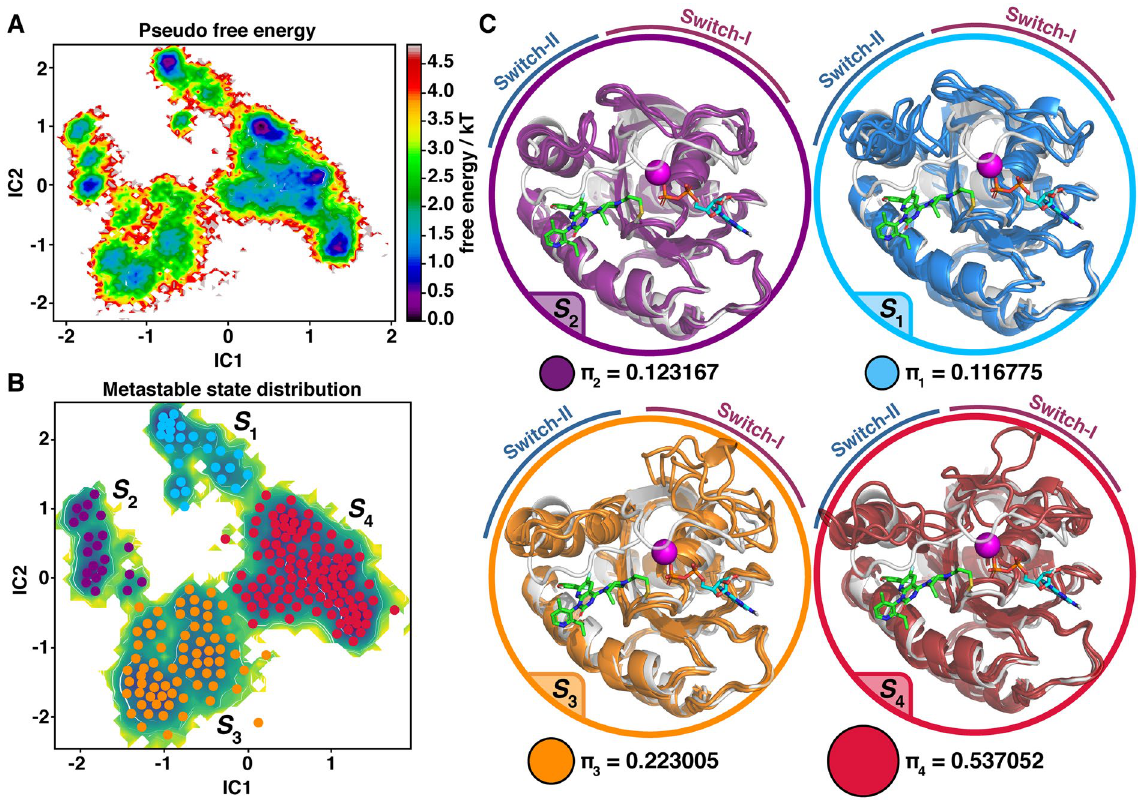
Figure 5. Metastable states of KRAS(G12C)–AMG 510 complex revealed by Markov state modelling. ( A ) Pseudo free energy map of distributions along time-lagged independent components (ICs) 1 and 2. ( B ) Separation of four metastable states ( S 1 – S 4 ) by PCCA++ analysis. ( C ) Visualization of the metastable states. Each metastable state ( S i ) is illustrated with three representative structures (coloured cartoons) and the crystal structure conformation of KRAS(G12C)–AMG 510 complex is shown as a reference in grey. Equilibrium probability ( π i ) for each state is indicated below the conformations together with circles with an area that is relative to state